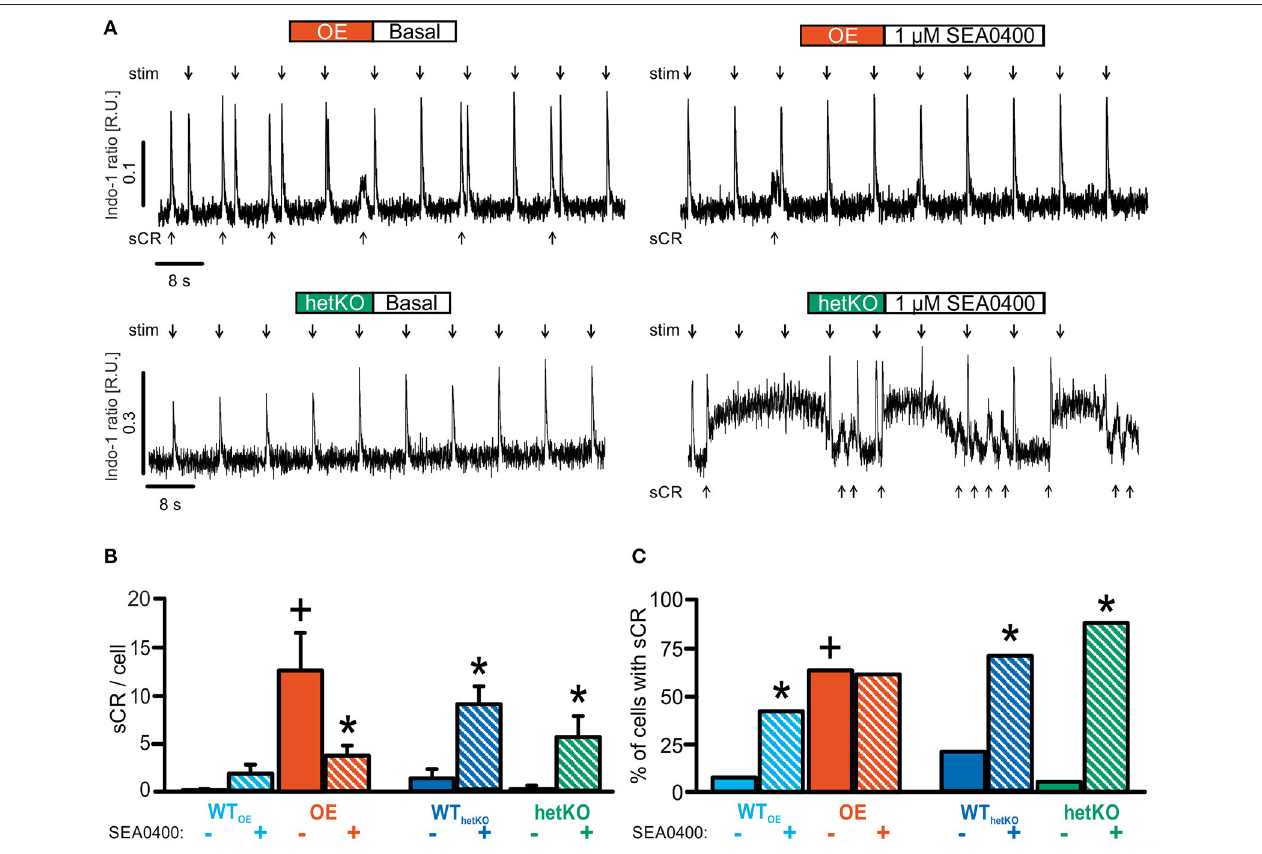
FIGURE 3 | Quantification of spontaneous Ca 2 + releases (sCR) as a measure for proarrhythmia. (A) Representative tracings illustrate the occurrence of numerous sCR (arrows below respective tracings) between field-stimulated Ca 2 + transients (stim, arrows above respective tracings) in OE but not in hetKO in absence of SEA0400. (B) Quantification of sCR/cell under basal conditions and during exposure with 1 µ M SEA0400. (C) Number of sCR-positive cardiomyocytes under basal conditions and during exposure with 1 µ M SEA0400. SEA0400 significantly reduced the occurrence of sCR/cell in OE. Conversely, in hetKO SEA0400 increased the occurrence of sCR. Hence, the effect of SEA0400 on the occurrence of proarrhythmic spontaneous Ca 2 + transients again depends on the NCX expression level. * p < 0.05 vs. basal; + p < 0.05 vs. corresponding WT basal; two-way repeated measures ANOVA test; z